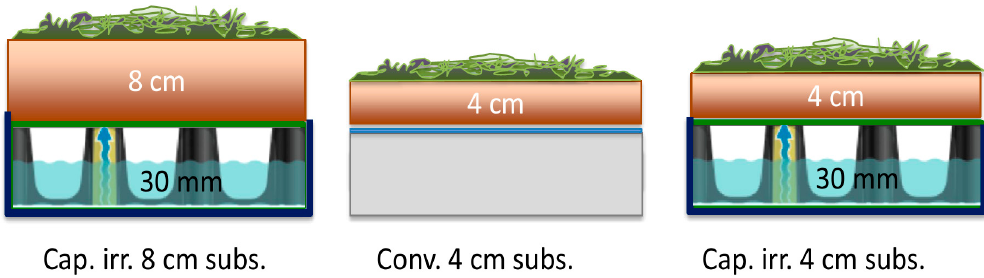
Figure 2. Schematic cross-sections of the three research plots. The left and right plot are equipped with the Permavoid drainage and capillary irrigation system.